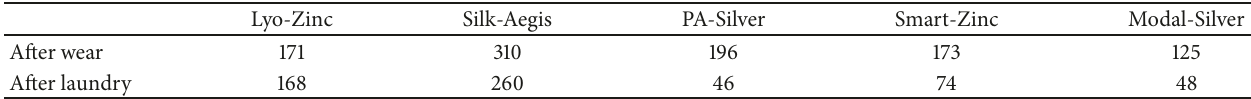
Table 3: Lipid absorption values of five AD fabrics after wearing a moisturising cream for 4 h and after laundry. All values are means of triplicates and shown in mgr/gr of textile